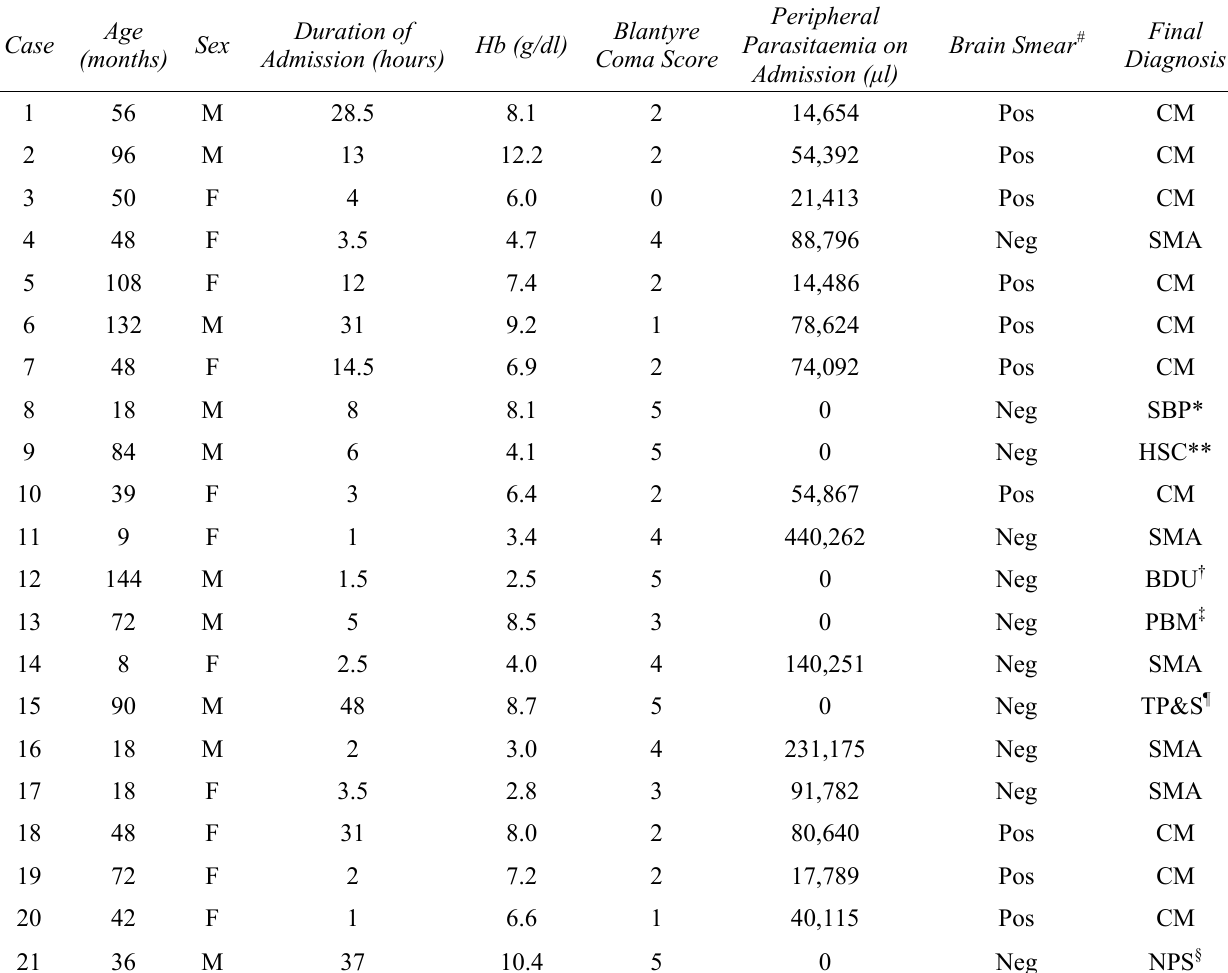
Table 1: Clinical and Diagnostic Details of the 21 Studied